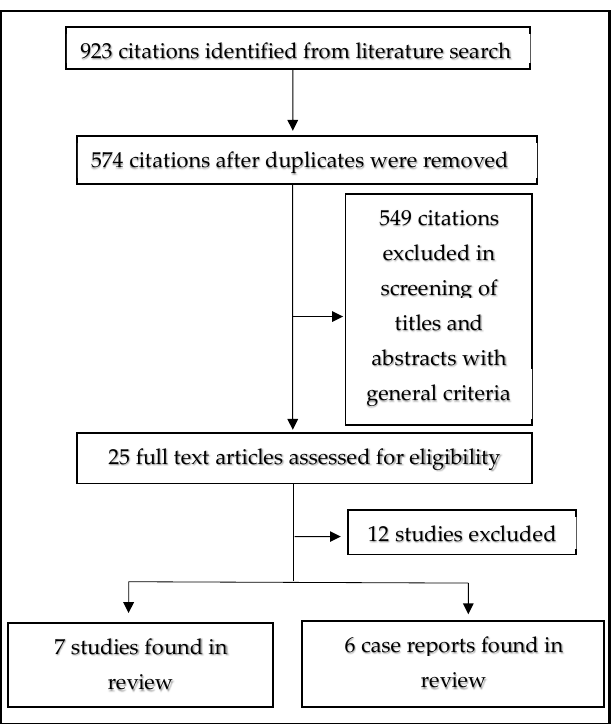
Figure 1. The fl ow chart of data collection and extraction. Figure 1. The flow chart of data collection and